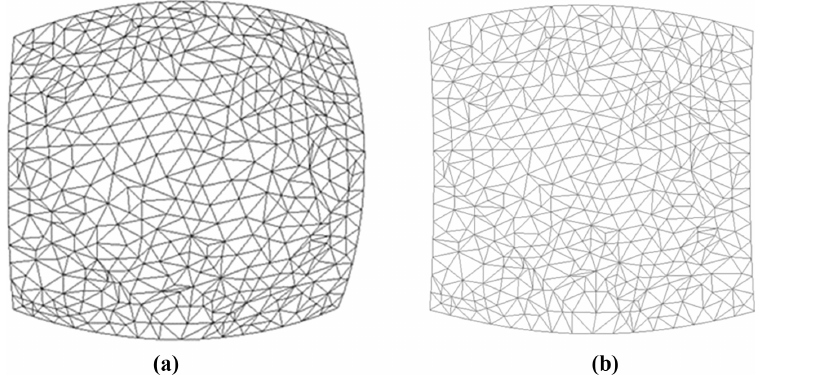
Figure 5. Intersectionsinasingle